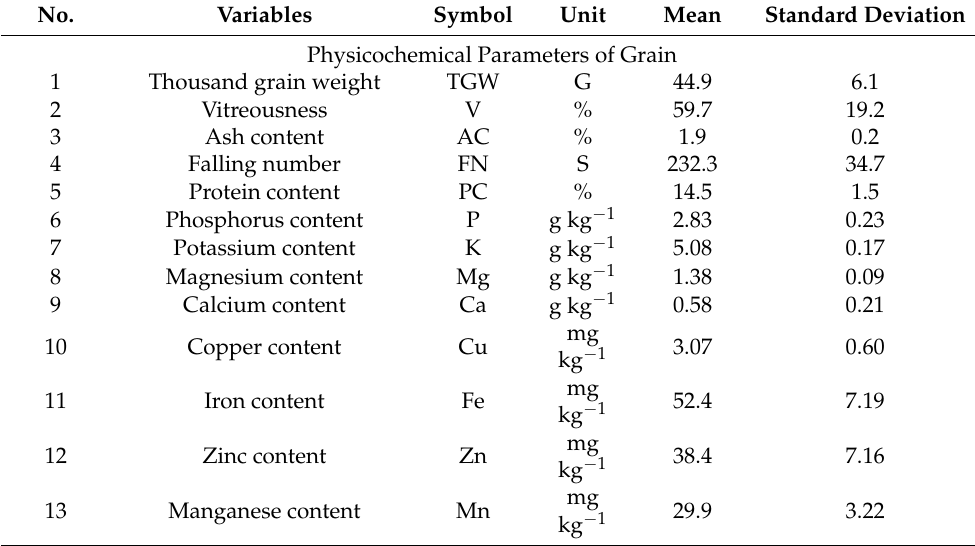
Table 1. Variables and descriptive statistics relating to durum wheat grain and milling quality pa- rameters.